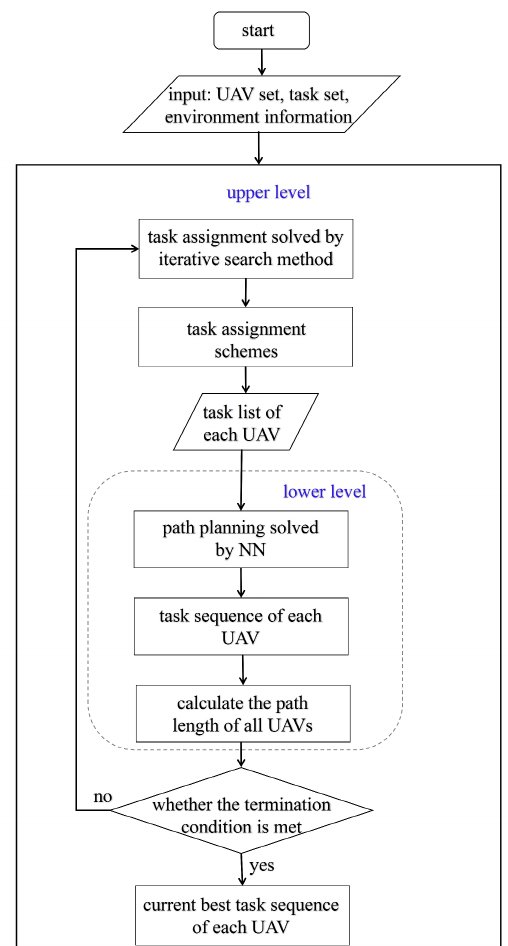
Figure 2. The bi-level problem-solving